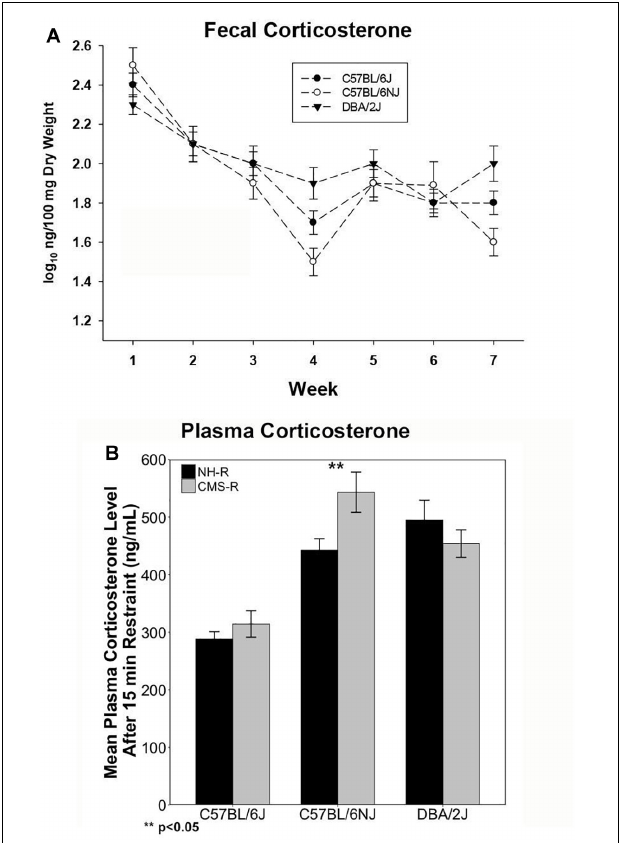
FIGURE 1 | Corticosterone Measures. Fecal CORT (fCORT) during seven weeks of CMS is shown in (A) and plasma CORT measured at the end of 15-min restraint in normal housed (NH-R) and CMS treated (CMS-R) animals is shown in (B) . Habituation to CMS is observed as a return to basal fCORT levels in all three strains as shown in (A) . The D and N strain have a more pronounced CORT response to acute restraint stress compared to the B strain as shown in (B) . The N strain shows a sensitized CORT response to an acute novel stressor (15 min of restraint) following CMS. There is a significant main effect of strain ( p < 0.001) and a significant strain-by-treatment interaction effect ( I < 0.05) on plasma CORT response. Only the N strain shows a significant difference in CORT response based on chronic stress exposure (NH-R vs. CMS-R, p < 0.05).